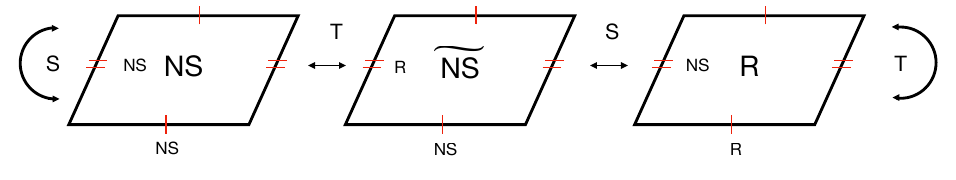
Figure 1 . Transformations among NS, f NS and R